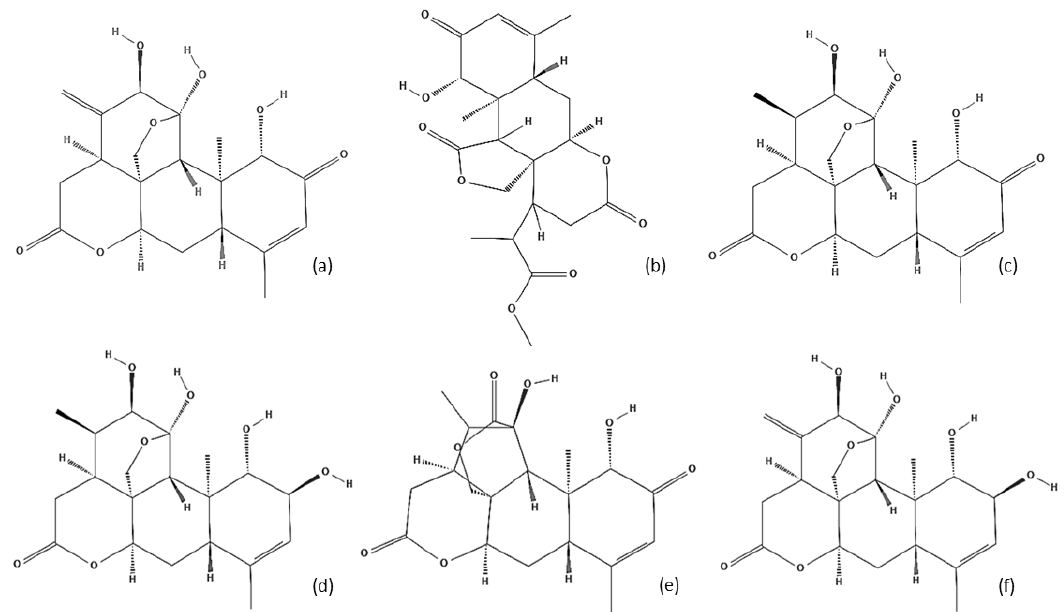
Appl. Sci. 2021 , 11 , x FOR PEER REVIEW 10 of 20 Figure 3. Some examples of the main A. altissima quassinoids identified: ( a ) Ailanthone; ( b ) Ailantinol A; ( c ) Chaparrinone; ( d ) Chaparrin; ( e ) Shinjudilactone; ( f ) Shinjulactone A.